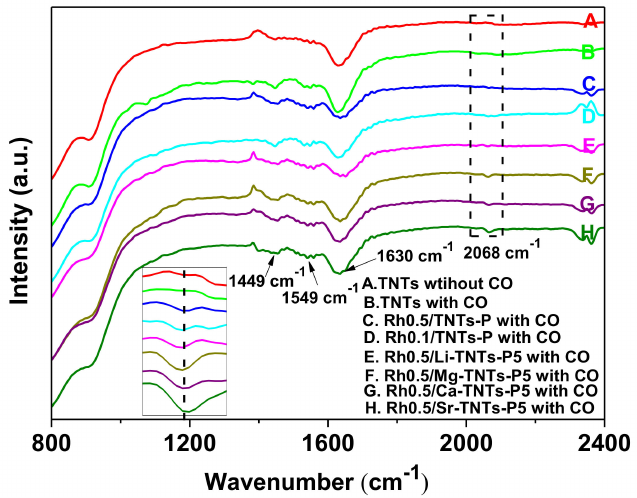
Figure 4. The FT-IR spectra of samples: TNTs without CO gas ( A ); TNTs with CO gas ( B ); Rh0.5/TNTs-P with CO gas ( C ), Rh0.1/TNTs-P with CO gas ( D ), Rh0.5/Li-TNTs-P5 with CO gas ( E ), Rh0.5/Mg-TNTs-P5 with CO gas ( F ), Rh0.5/Ca-TNTs-P5 with CO gas ( G ), and Rh0.5/Sr-TNTs-P5 with CO gas ( H ). Inset: expanded view between 2040 and 2090 cm − 1